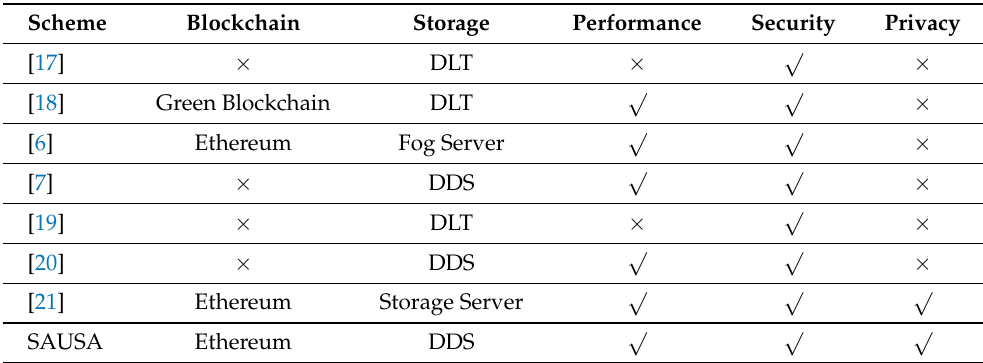
Table 2. Comparison among existing Blockchain-based